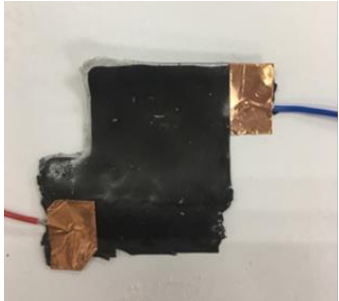
Figure 13. Printing result of a piezoelectric sensing pad.